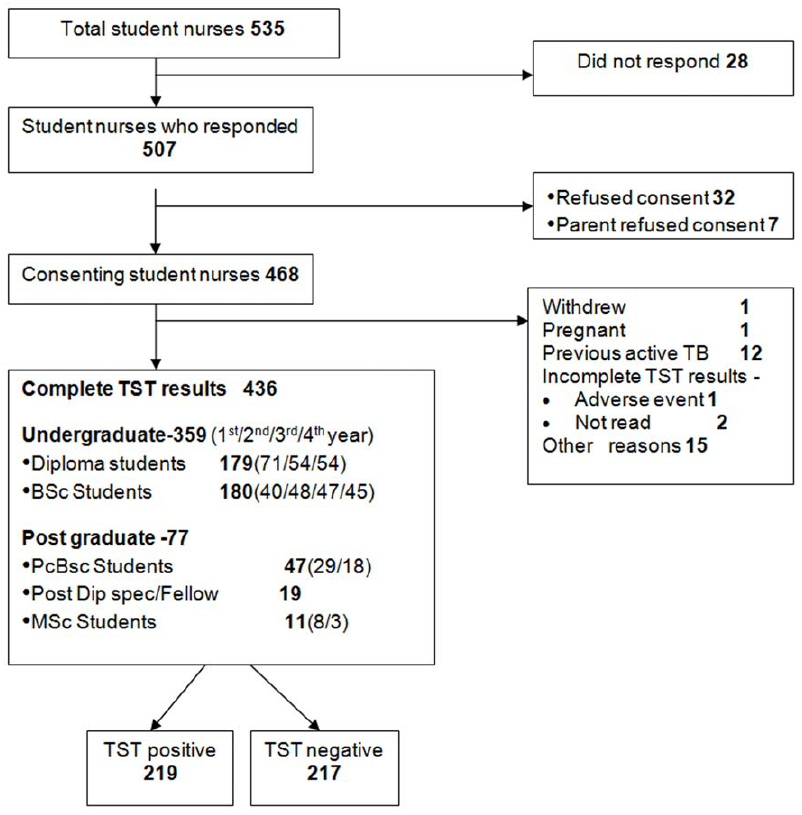
Figure 1. Study flow chart.